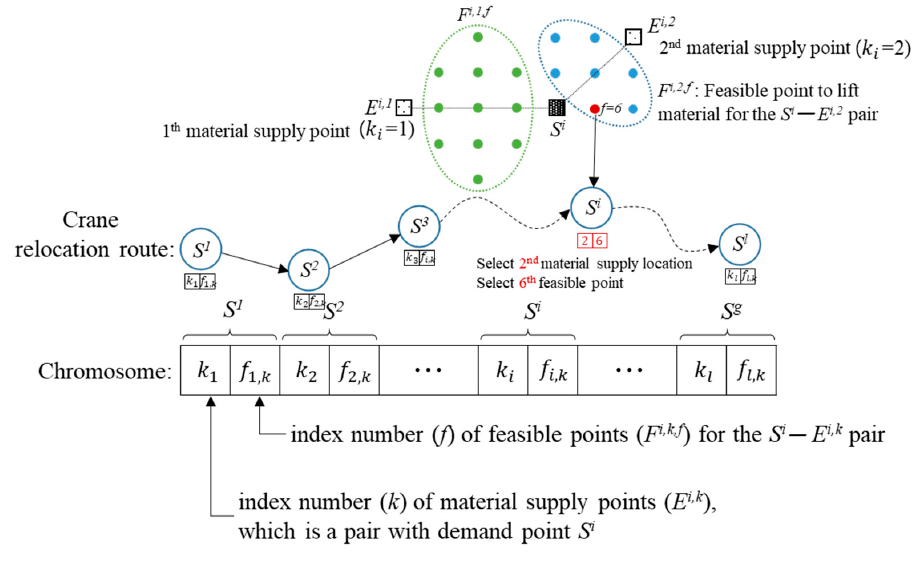
Figure 3. Encoding a chromosome.